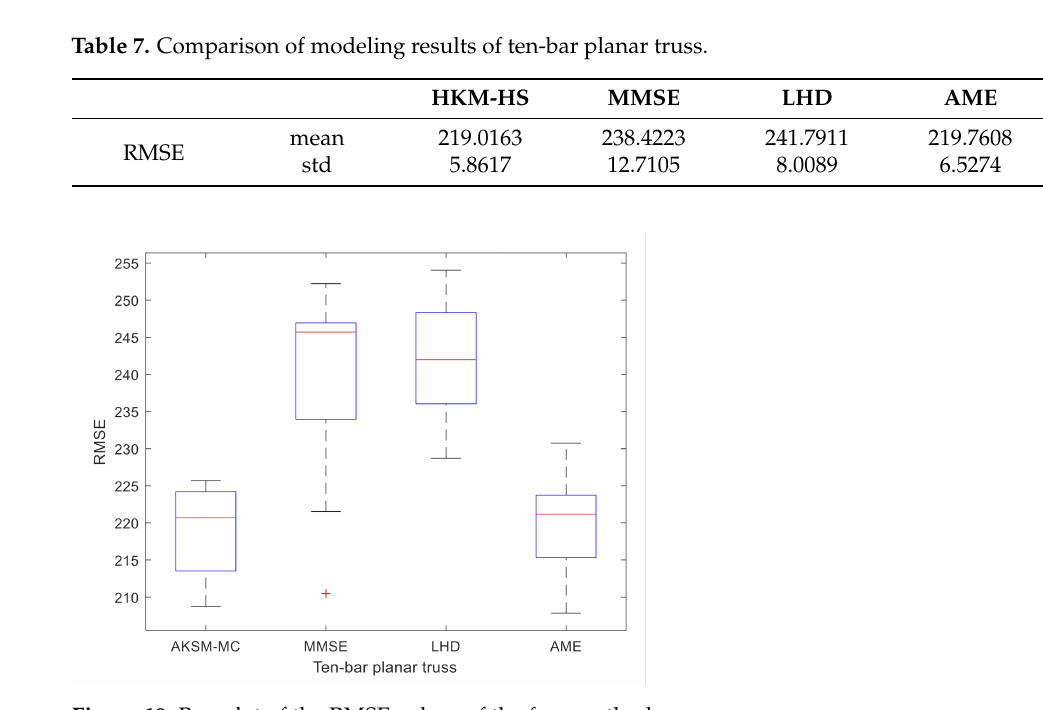
Figure 18. Box plot of the RMSE values of the four